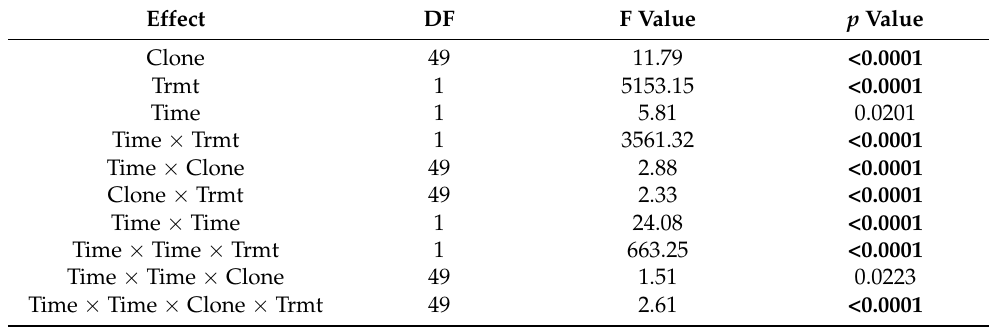
Table 3. Repeated measures quadratic polynomial analysis of variance results for SPAD measurement.